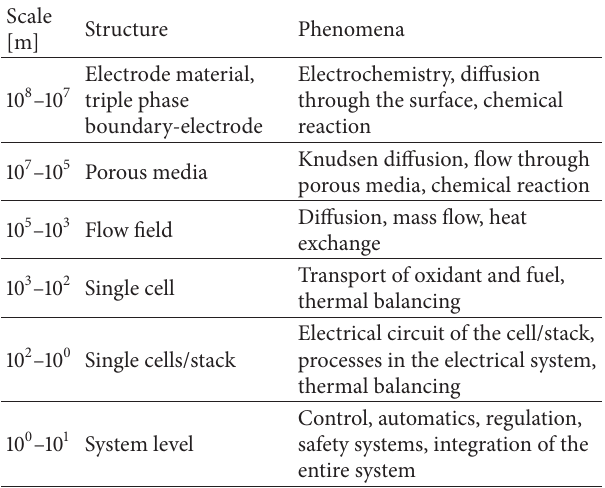
Table 1: Different processes and their corresponding length scales [after